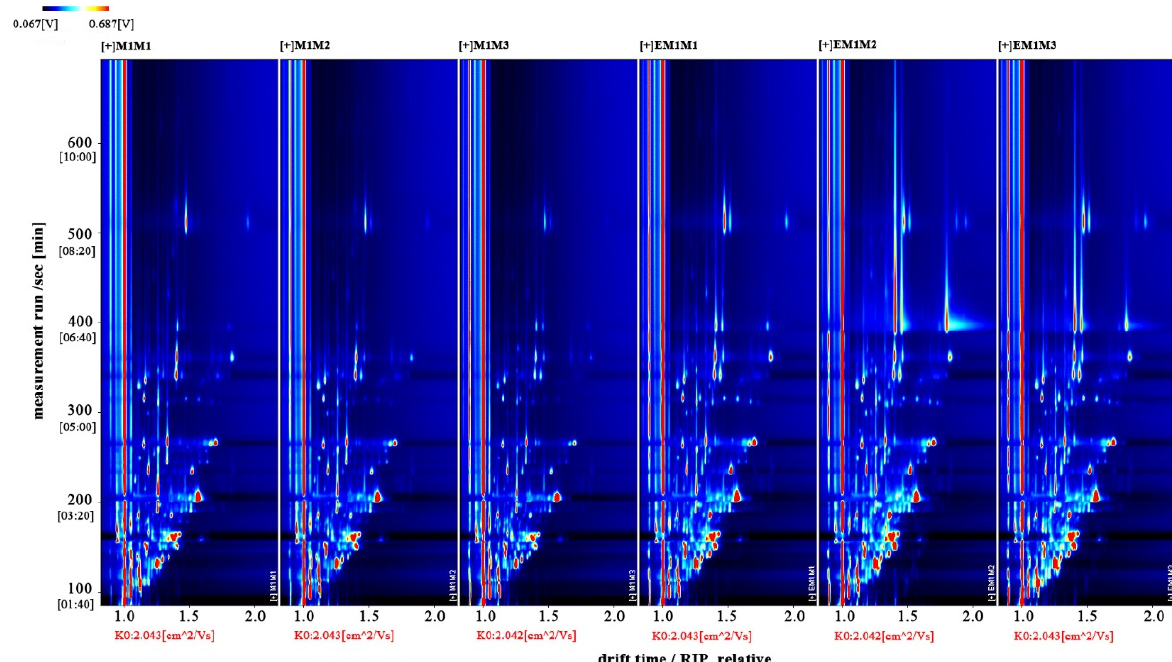
Figure 3. Gas-phase ion mobility spectra of Micropterus salmoides muscles. Note: M1M1, M1M2, and M1M3: three samples from the M group. EM1M1, EM1M2, and EM1M3: three samples from the EM group. The background is blue, and the red vertical line on the abscissa (1.0) is the normalized reaction peak. The y-axis represents the retention time of gas chromatography, and the x-axis represents the ion relative drift time. Points on both sides of the reaction peak represent volatile organic compounds. Colors indicate the concentration of substance, with white and red representing a low and high concentration, respectively. The deeper the color, the higher the concentration. For the interpretation of references to colors in this figure legend, please refer the web version of this this article.